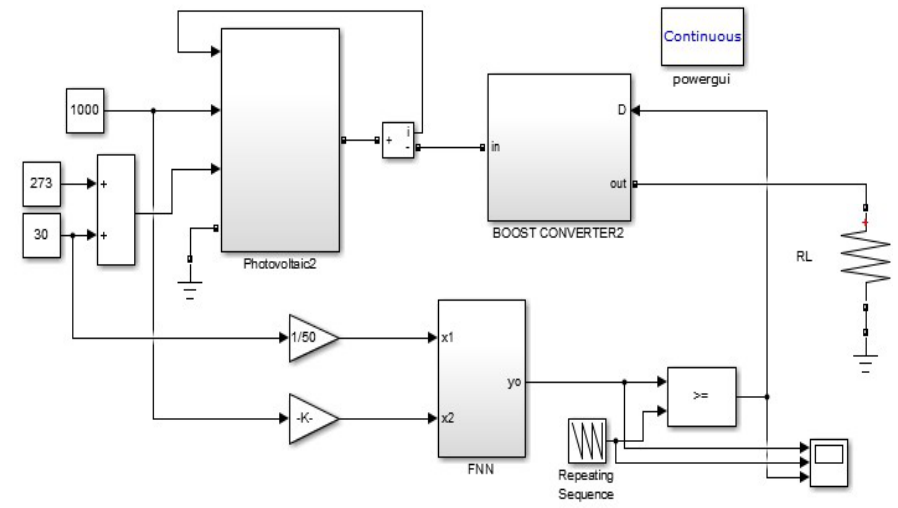
Figure 5. The Simulink model of the overall PV system with the proposed controller based on MPPT.